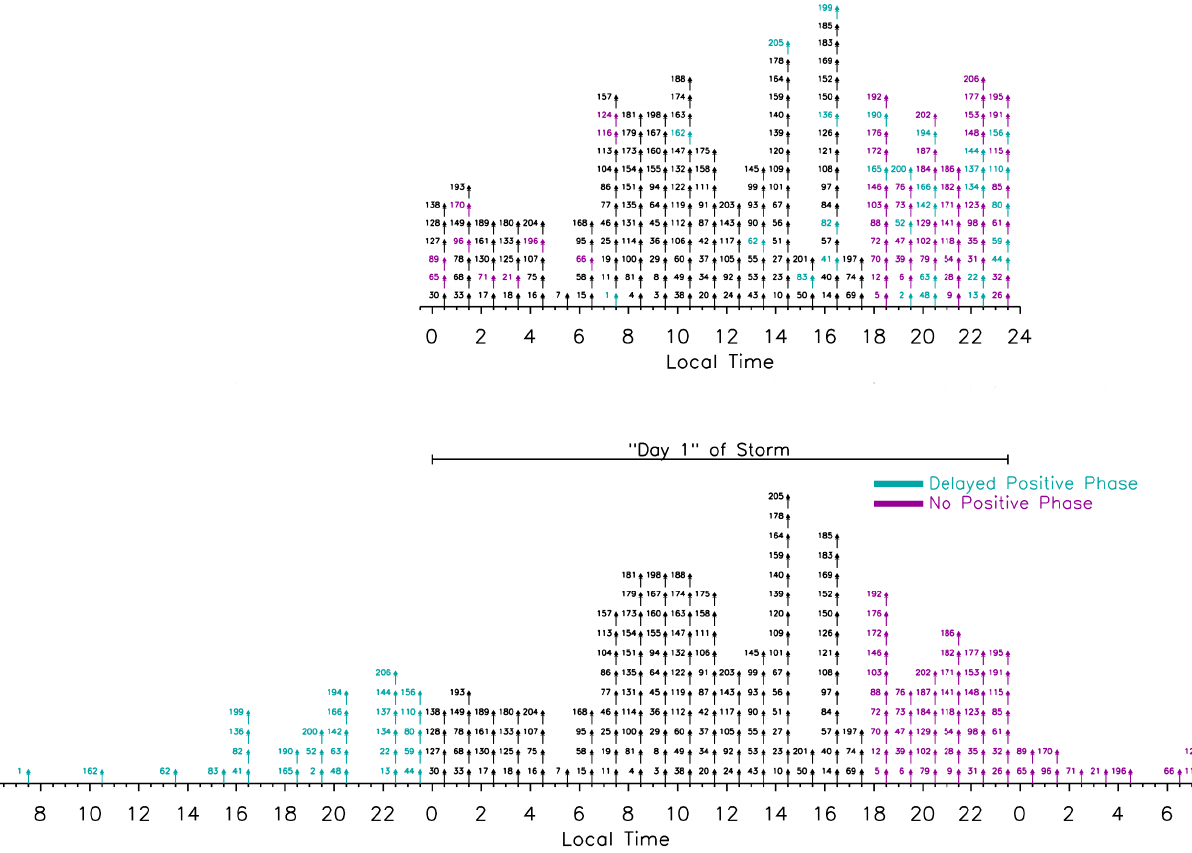
Fig. 3. Top: The distribution of the 206 storm commencement times used in this study arranged in local time at Wallops Island. Bottom: Using the pattern characterization scheme portrayed in Fig. 2 (left), the regular-positive-phase (RPP) storms, the no-positive-phase (NPP) and delayed-positive-phase (DPP) storms are shown distributed among the three possible 24-h local time periods used for computing average patterns. Day 1 in this scheme is the day of the afternoon dusk effect. Finally, color coding is used to show how the NPP (magenta) and the DPP (turquoise) storms are shifted. Storms 67, 21 and 190 are the examples shown in Fig. 2